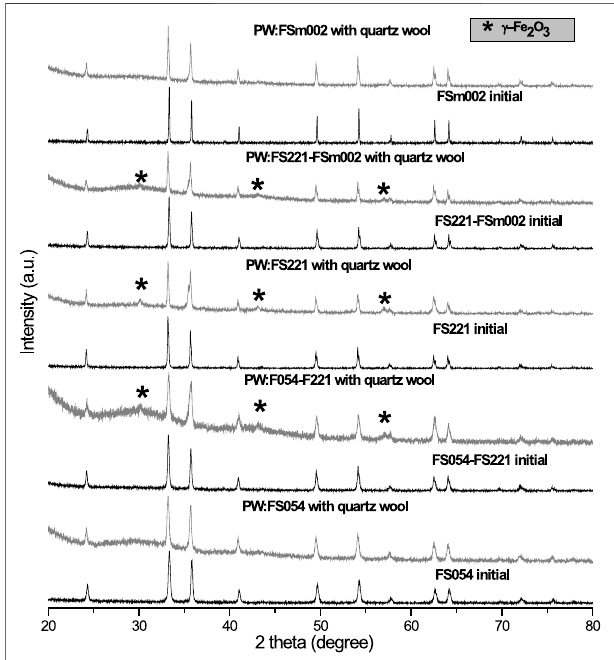
FIGURE1| XRDpatternsof α -Fe 2 O 3 withdifferentsizesinitiallyandafter CFP. After CFP the XRD patterns of the catalysts were recorded with a small amount of quartz wool, which was used to fi x a catalyst with biomass in the pyroprobe, and it was challenging to separate it without loss of catalyst.